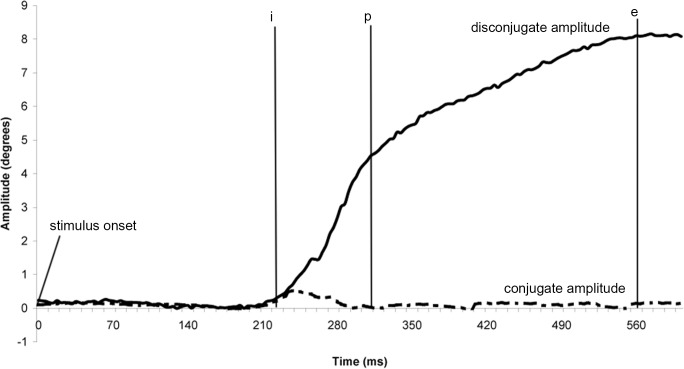
Typical recording of a convergence eye movement.Markers ‘i’ and ‘e’ indicate the onset and the offset of vergence eye movement based on the criterion of 5°/s velocity threshold. Marker ‘p’ indicate the separation between the phasic and tonic part of the movement. Full line: disconjugate amplitude; dotted line: conjugate amplitude.